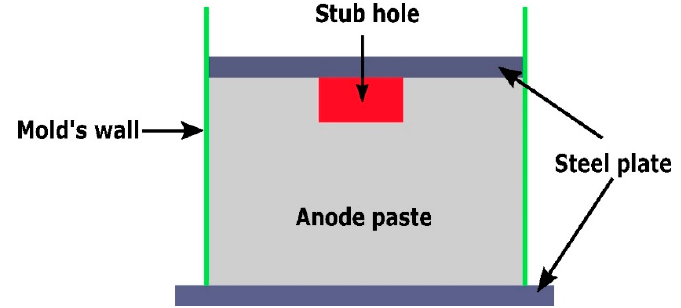
Figure 9. Cross-sectional view of the compaction test with the stub hole.